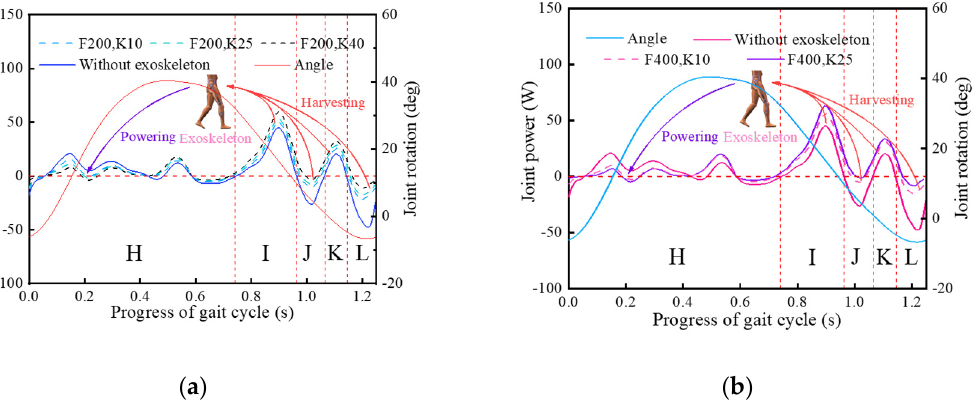
Figure 10. ( a ) Pressure spring with the initial compression force of 200 N; ( b ) Pressure spring with the initial compression force of 400 N.